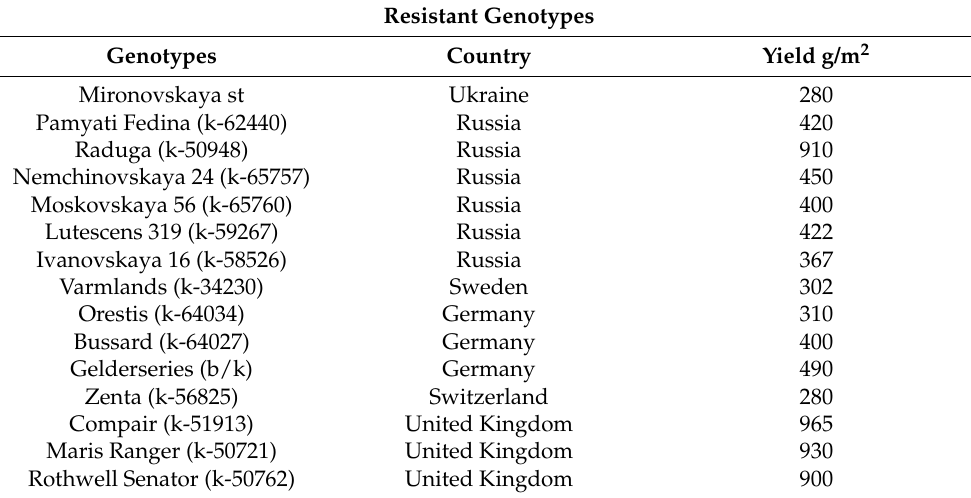
Table 7. Yield of the resistant genotypes (2002–2003).